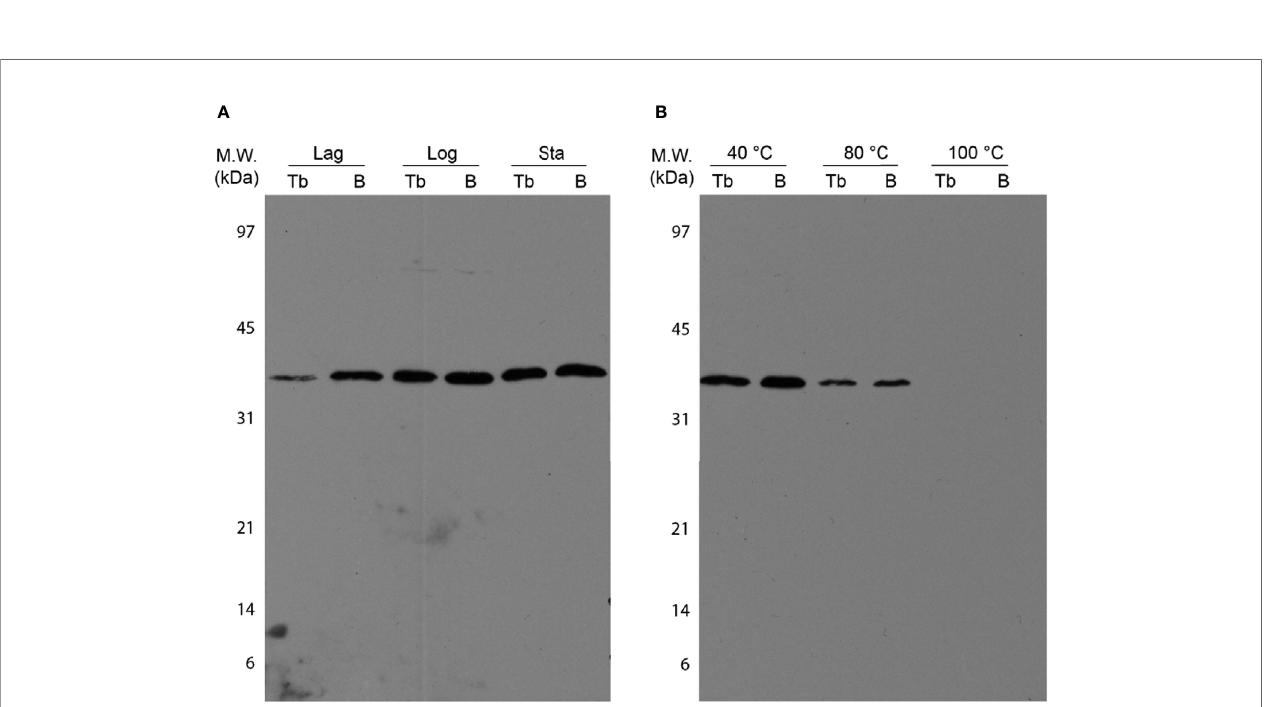
FIGURE 7 | Characterization of M.tb (Tb) and BCG Moreau (B) native dodecins by western blotting. Prior to western blotting, 20 µg of total proteins from BCG Moreau and M.tb clari fi ed lysates were resolved on 15% SDS-PAGE. (A) Expression during axenic growth was analyzed on Lag, logarithmic (Log) and stationary (Sta) phases. (B) Thermostability assays were performed incubating protein samples at 40, 80 and 100 °C for 30 min prior to sample clari fi cation by centrifugation and subsequent analysis by western blotting. Results are representatives of a set of three independent